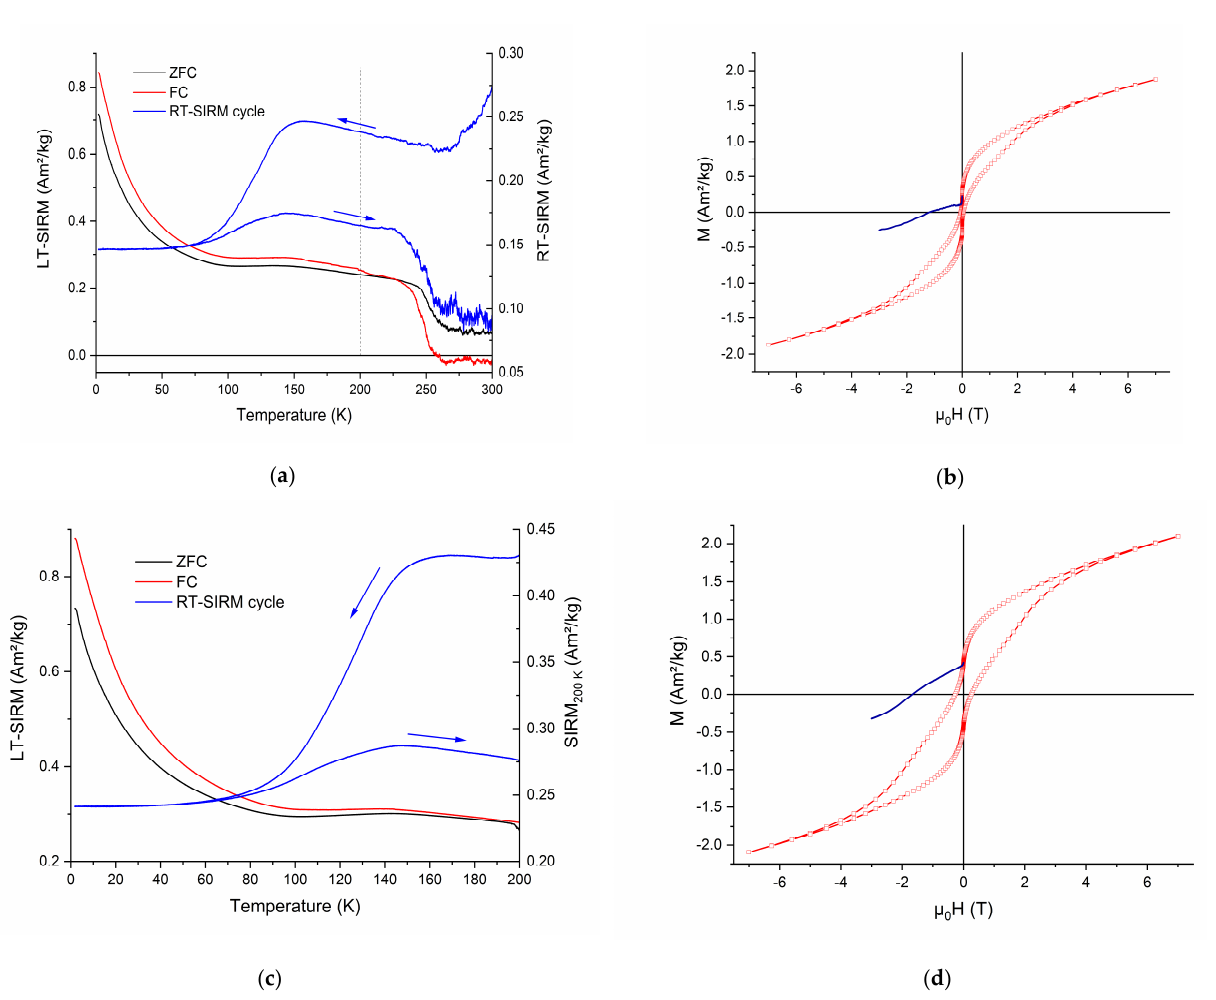
Figure 4. Illustration of the collapse of magnetic signal in ε-Fe 2 O 3 , sample S300N: ( a ) Low-temperature remanence behavior between 1.8 K and 300 K; ( b ) Hysteresis loop and backfield demagnetization curve measured at 295 K; ( c ) Low-temperature remanence behavior between 1.8 K and 200 K; ( d ) Hysteresis loop and backfield demagnetization curve measured at 200 K.